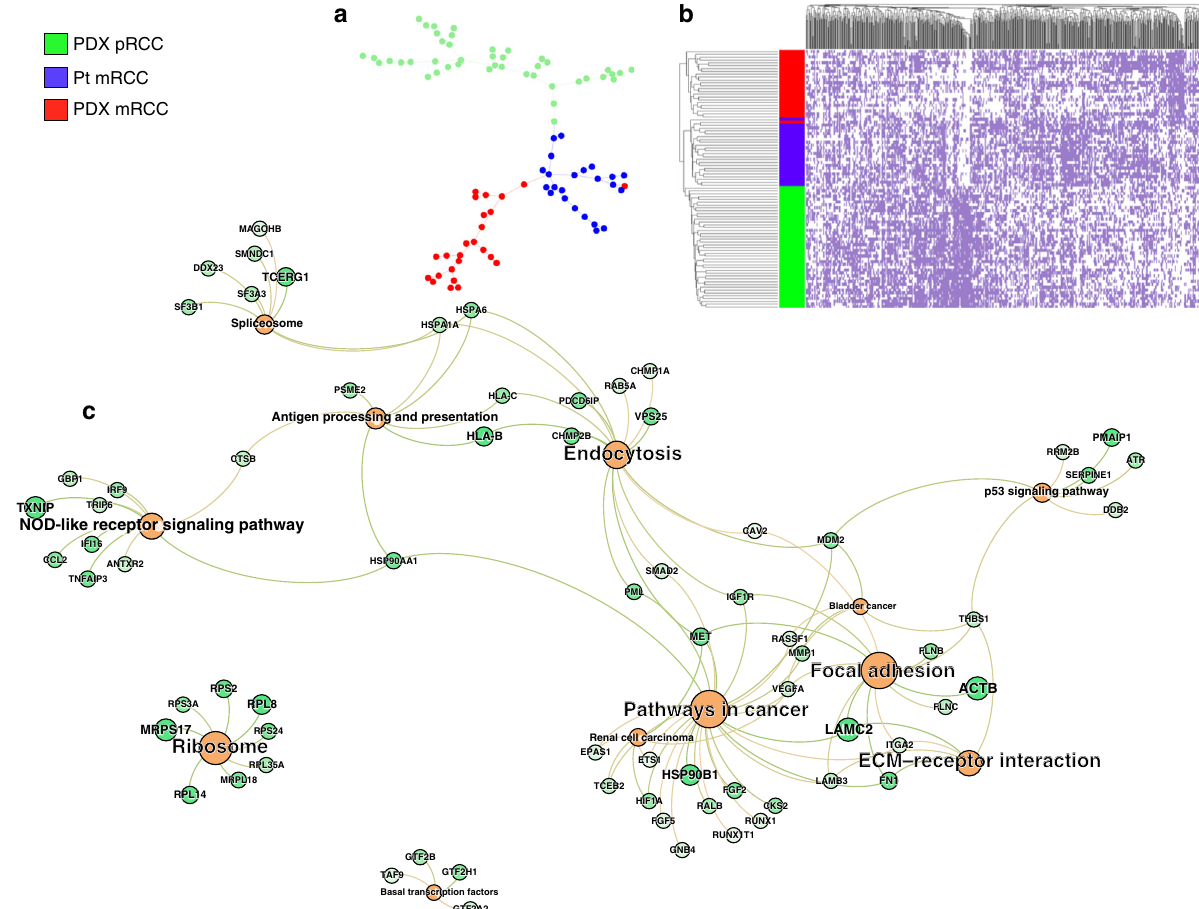
Fig. 6 Heterogeneity revealed by Kim dataset. a Pseudo-time ordering reconstruction of the different subgroups: single cells from PDX primary tumor (green), patient metastasis (blue) and PDX metastasis (red). The eeSNVs are obtained with a = 0.6. The tree is inferred using the MST algorithm on Pearson ’ s correlation-based distance matrix. b Heatmap of the cells (row) and eeSNVs (column). c Bipartite graph using KEGG pathways (orange color) and genes enriched with signi fi cant eeSNVs (green color) as two set of nodes. The signi fi cant eeSNVs are inferred from the metastasized cells, compared to the primary tumor cells. The size of the nodes re fl ects the gene scores (given by SSrGE) and the pathway scores (sum of the gene scores). Lighter green indicates genes with a lower